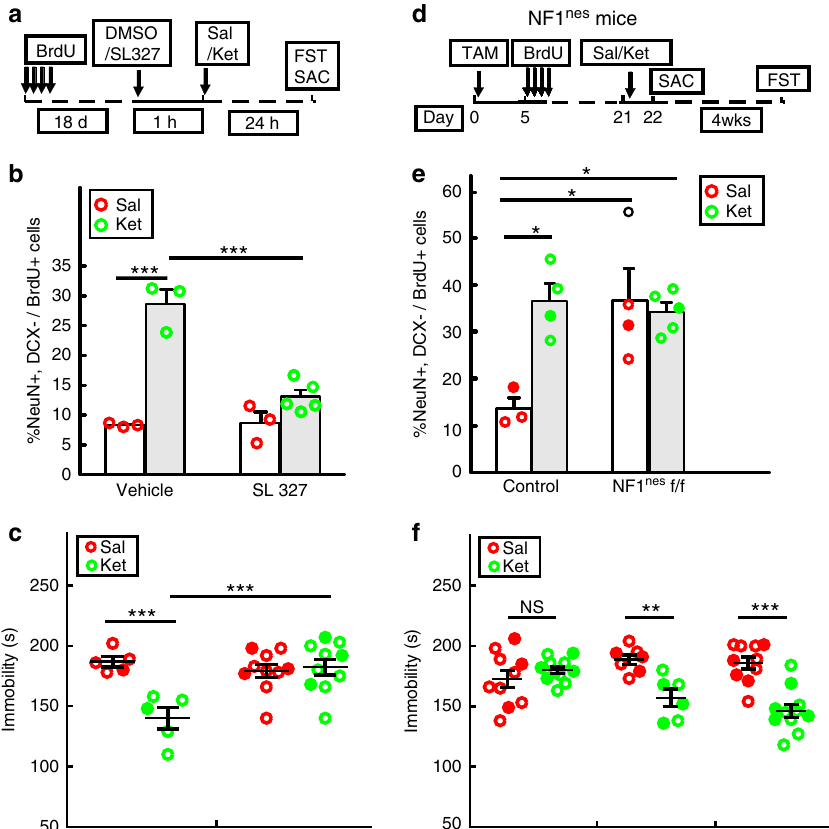
Fig. 7 ERK pathway regulates the anti-depressive effect of ketamine. a The MEK inhibitor, SL327, was administrated to mice 1 h before saline (Sal) or ketamine (Ket) treatment and FST was tested 24 h later. Newborn cells were labeled with BrdU 18 days prior to the drug treatments. b Ketamine signi fi cantly increases the percentage of newborn neurons only in vehicle treated mice, but not in mice pre-treated with the MEK inhibitor (BrdU+ cell number quanti fi ed in the DG is 180 ± 4.3, 135.3 ± 13.3, 215.6 ± 7.9, 236.1 ± 32.3, respectively; two-way ANOVA, Tukey post hoc, *** p < 0.001 for saline vs ketamine in vehicle mice and for ketamine-treated vehicle vs SL327). c Mice pretreated with SL327 do not exhibit reduced immobility time in the FST following ketamine treatment (two-way ANOVA with unweighted mean analysis, Tukey post hoc, *** p = 3.46E − 4 for saline vs ketamine in vehicle